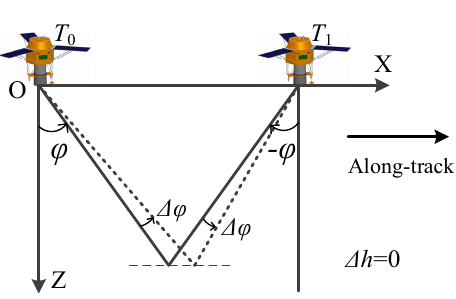
Figure 2. Elevation errors at the stereo intersection. The solid line shows the true intersection; the dashed line shows the intersection with error.